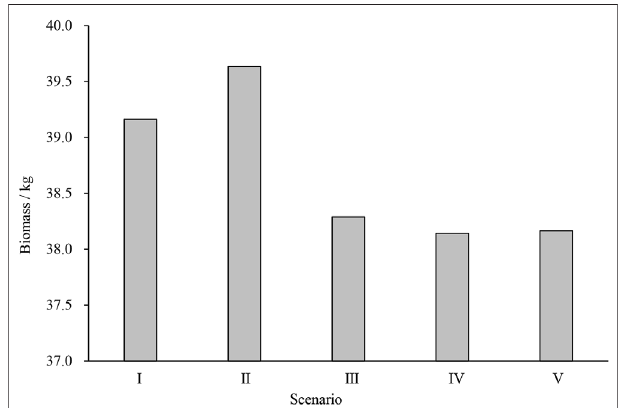
FIGURE7| Stockingeffectsofthereleased fi shonbiomassreplenishing under scenarios. Scenarios I to V indicated that the total number of fi sh were released in one, two, three, four, and seven events, respectively, with different intervals during 6 months.